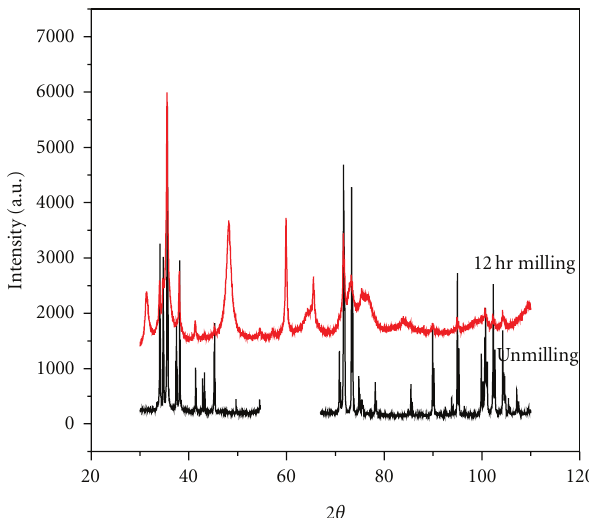
Figure 2: X-ray di ff raction of both milled (12hrs) and unmilled SiC